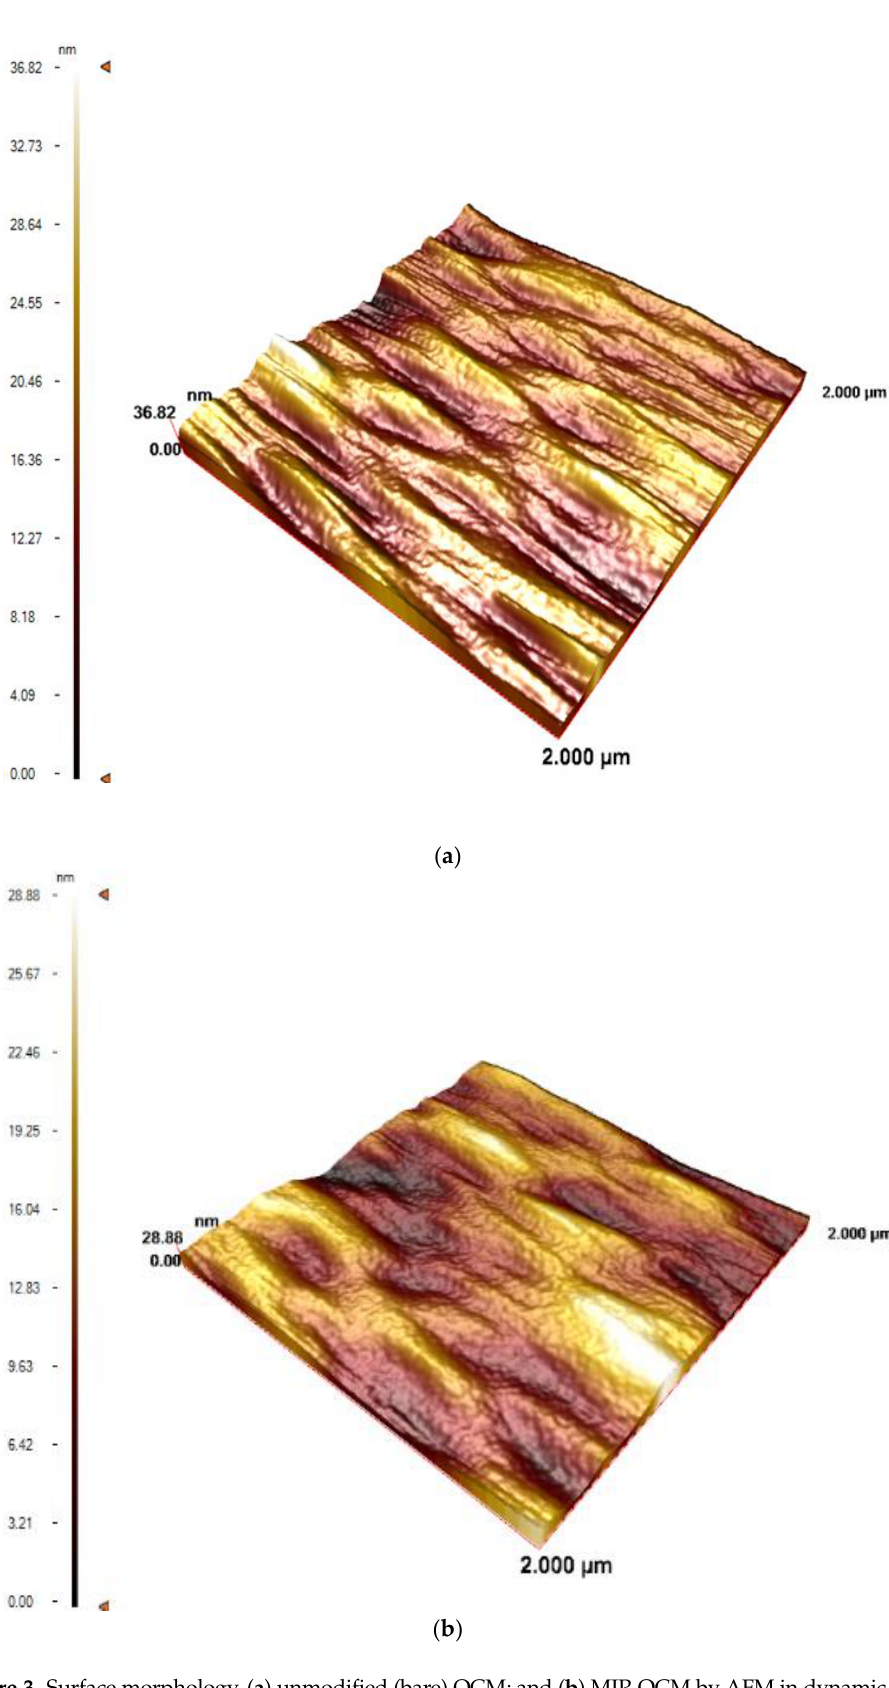
Figure 3. Surface morphology, ( a ) unmodified (bare) QCM; and ( b ) MIP-QCM by AFM in dynamic mode.